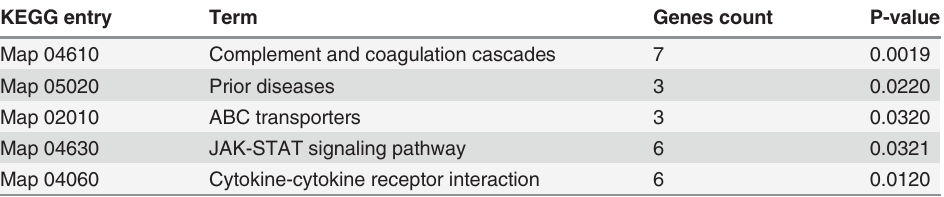
Table 3. Pathways identi fi ed by the Database for Annotation, Visualization and Integrated Discovery (DAVID version 6.7) in the Kyoto Encyclopedia of Genes and Genomes